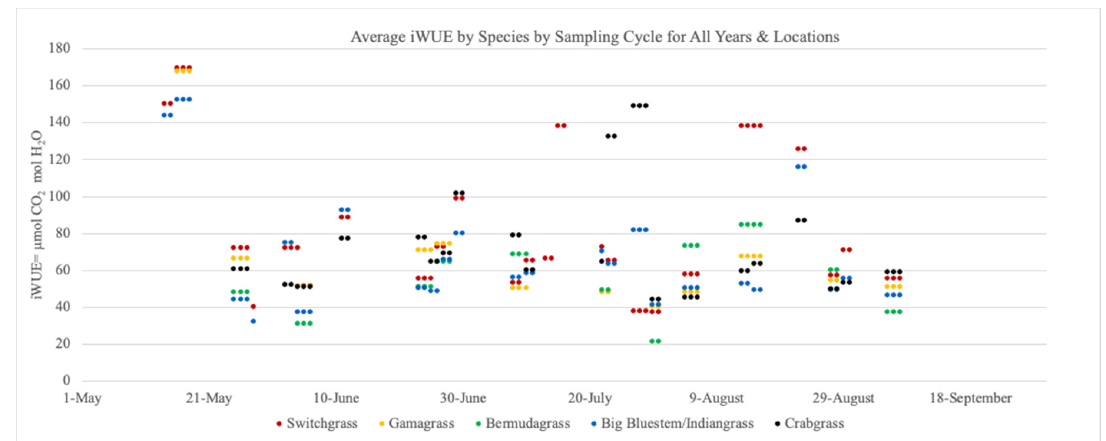
Figure 1. Mean instantaneous water-use (iWUE) per experimental unit (paddock) by species and sampling cycle at Highland Rim AgResearch and Education Center, Springfield, TN, and Ames Plantation AgResearch and Education Center, Grand Junction, TN, 2014–2016.